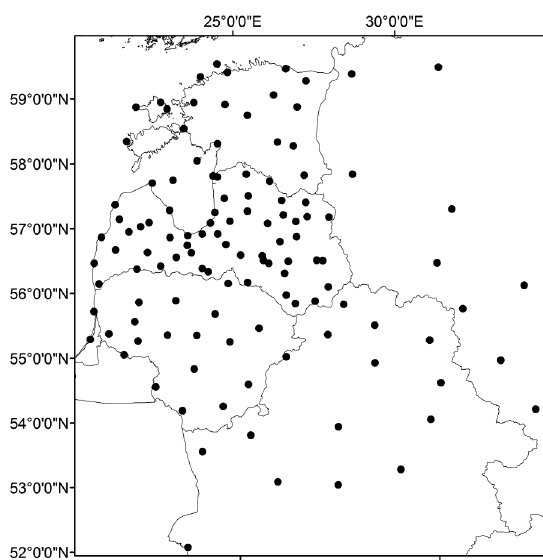
Fig. 2. Locations of meteorological stations used for bias correction of the